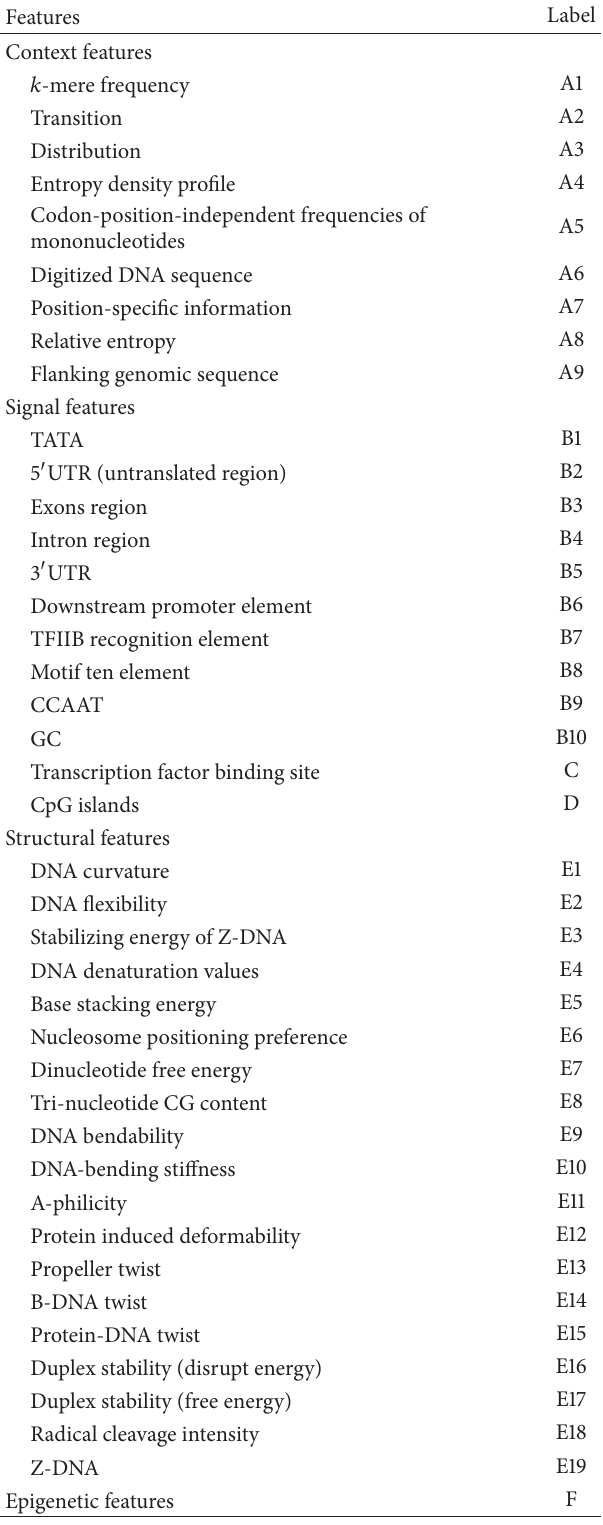
Table 1: Conventional features for promoter